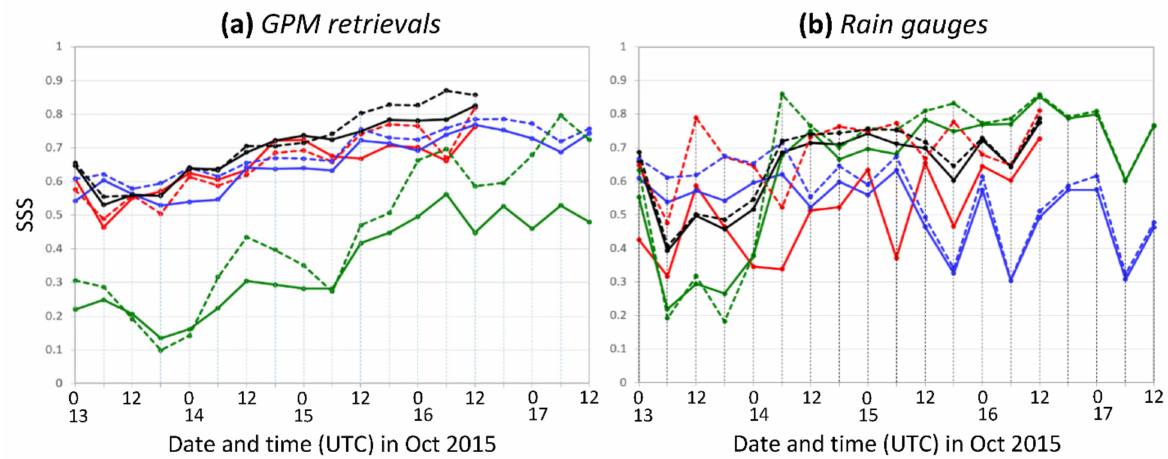
Figure 13. As in Figure 8, except for SSS of 24 h QPFs for the three target periods from 1200 UTC on 16 to 1200 UTC on 17 (red), 1200 UTC on 17 to 1200 UTC on 18 (blue), and 1200 UTC on 18 to 1200 UTC on 19 October (green) and 72 h QPFs for the period from 1200 UTC on 16 to 1200 UTC on 19 October during TY Koppu (2015), computed over the big (solid) and small (dashed) domains using ( a ) GPM rainfall retrievals and ( b ) rain gauge observations. The two domains are shown in Figure